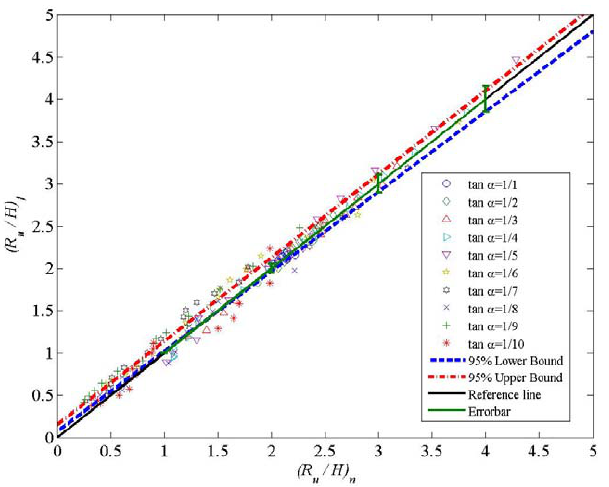
0.0 Figure 9. Verification of empirical formulae using datasets of Granthem (1953) and Saville 2 Fig. 9. Verification of empirical formulae using datasets of (1955). Line (1) is Hunt’s (1959) formula and Eq. (10a); Line (2) is Hunt’s (1959) formula of 3 Granthem (1953) and Saville (1955). Line (1) is Hunt’s (1959) for- / 3 R H  ; others are Eq. (10b). Granthem’s data are given by solid markers and Saville’s 4 mula and Eq. (9a); Line (2) is Hunt’s (1959) formula of R/H = 3; others are Eq. (9b). Granthem’s data are given by solid markers and data are hollow markers. 5 Saville’s data are hollow